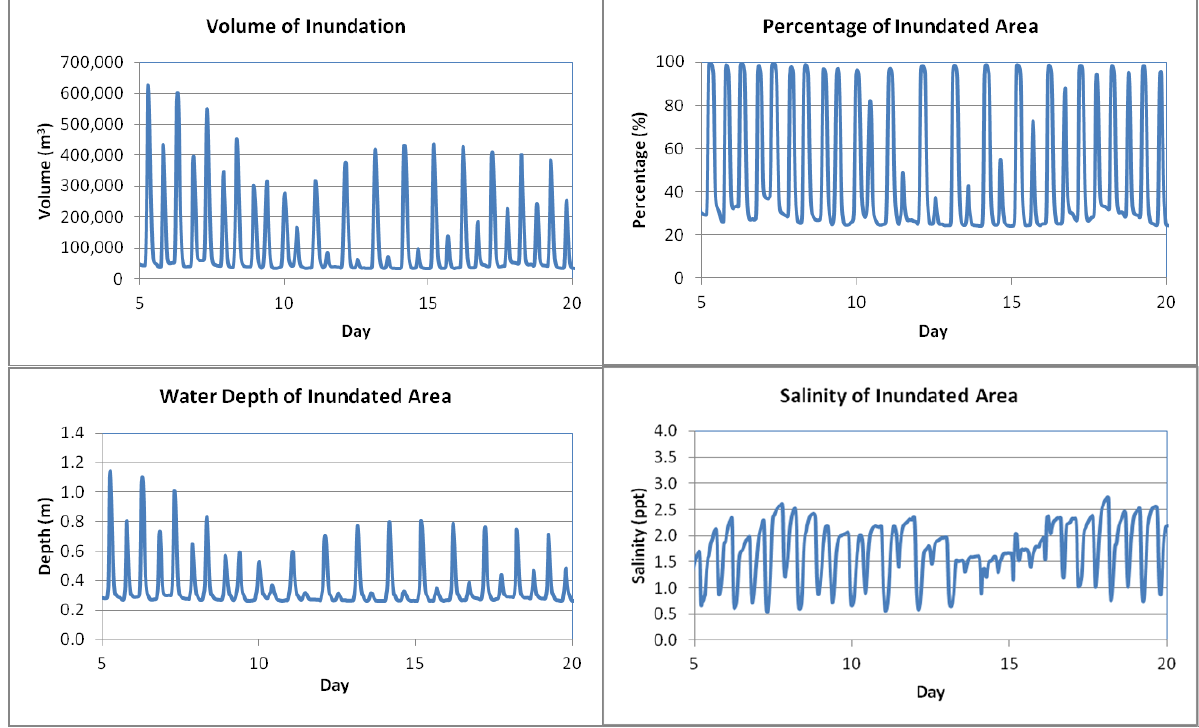
Figure 7. Hydrodynamic parameters for characterization of nearshore